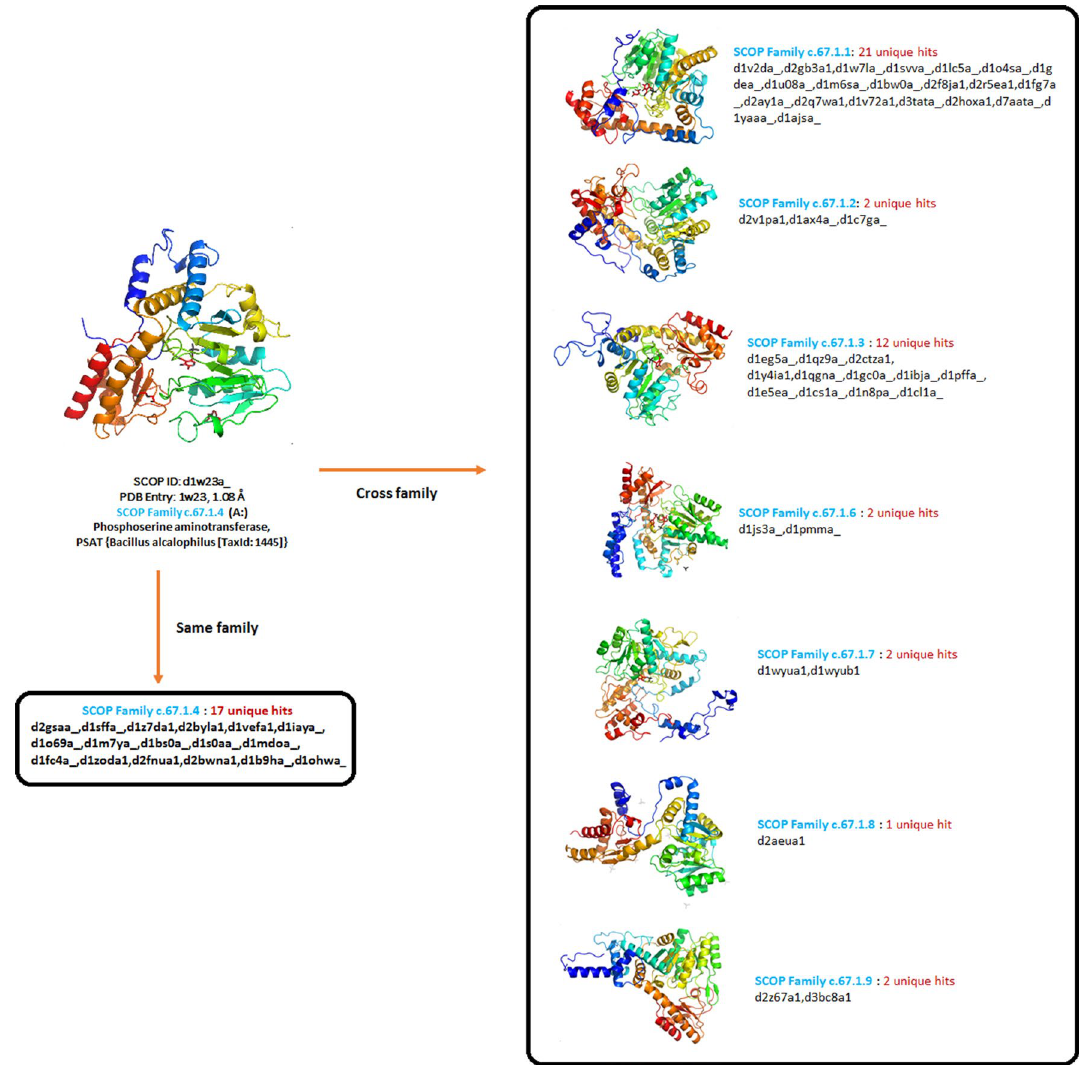
Figure 5. Three-dimensional structure of Phosphoserine aminotransferase, PSAT encoded by Bacillus alcalophilus [TaxId: 1445]} (SCOP ID: d1w23a_). Unique hits reported by Master Blaster from the same family and from the cross families are given.